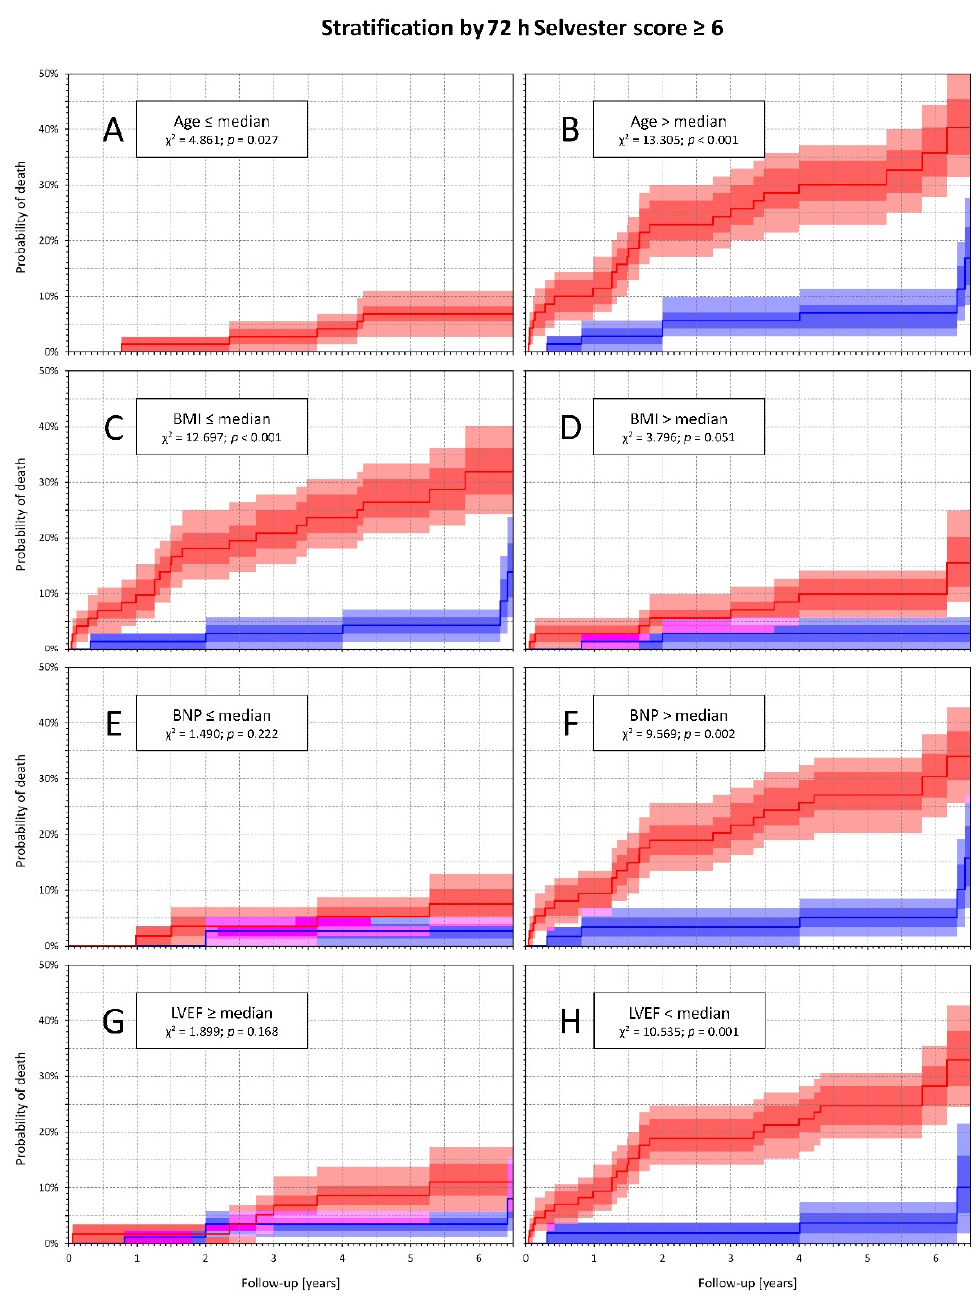
Figure 2. Kaplan–Meier analysis of probability of death in subpopulations defined by various clinical variables dichotomized at population medians and further dichotomized by the presence or absence of 72 h Selvester score ≥ 6. The panels show comparisons in particular subpopulations dichotomized by presence of 72 h Selvester score ≥ 6 (red line) or 72 h Selvester score <6 (blue line). Panel ( A )—age below median, there were no deaths for age below median with 72 h Selvester score <6; panel ( B )—age above median; panel ( C )—BMI below median; panel ( D )—BMI above median; panel ( E )—BNP below median; panel ( F )—BNP above median; panel ( G )—LVEF above median; panel ( H )—LVEF below median. In all panels, inter-quartile ranges are shown as the darker areas and 90% confidence intervals as the lighter areas.